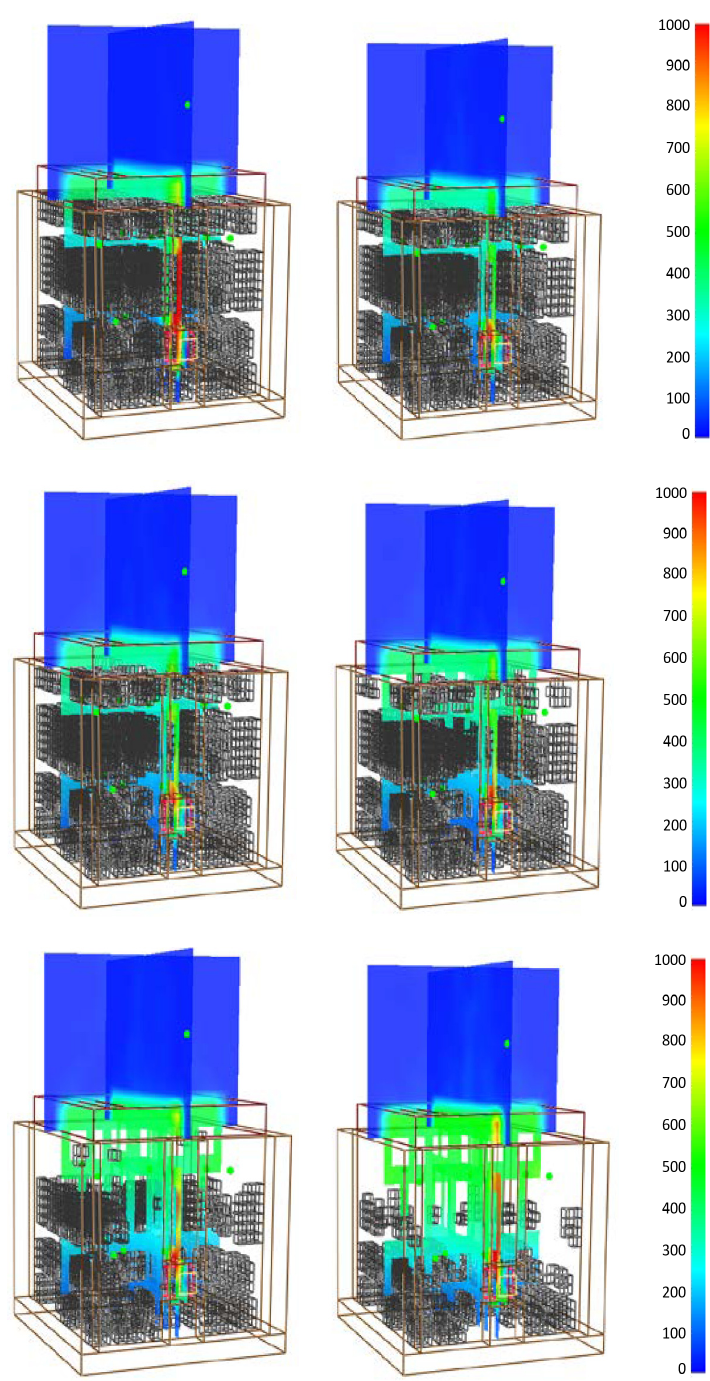
Figure 8. Temperature evolution and combustion progress in the computational fluid dynamics (CFD) - Fire Dynamics Simulator (FDS) model, in °C.